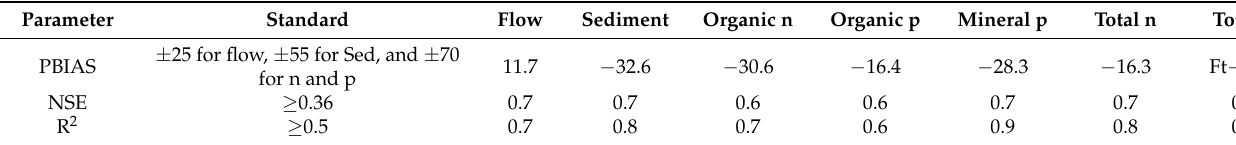
Table 2. Evaluation criteria: calibration. Table 3. Evaluation criteria: validation.